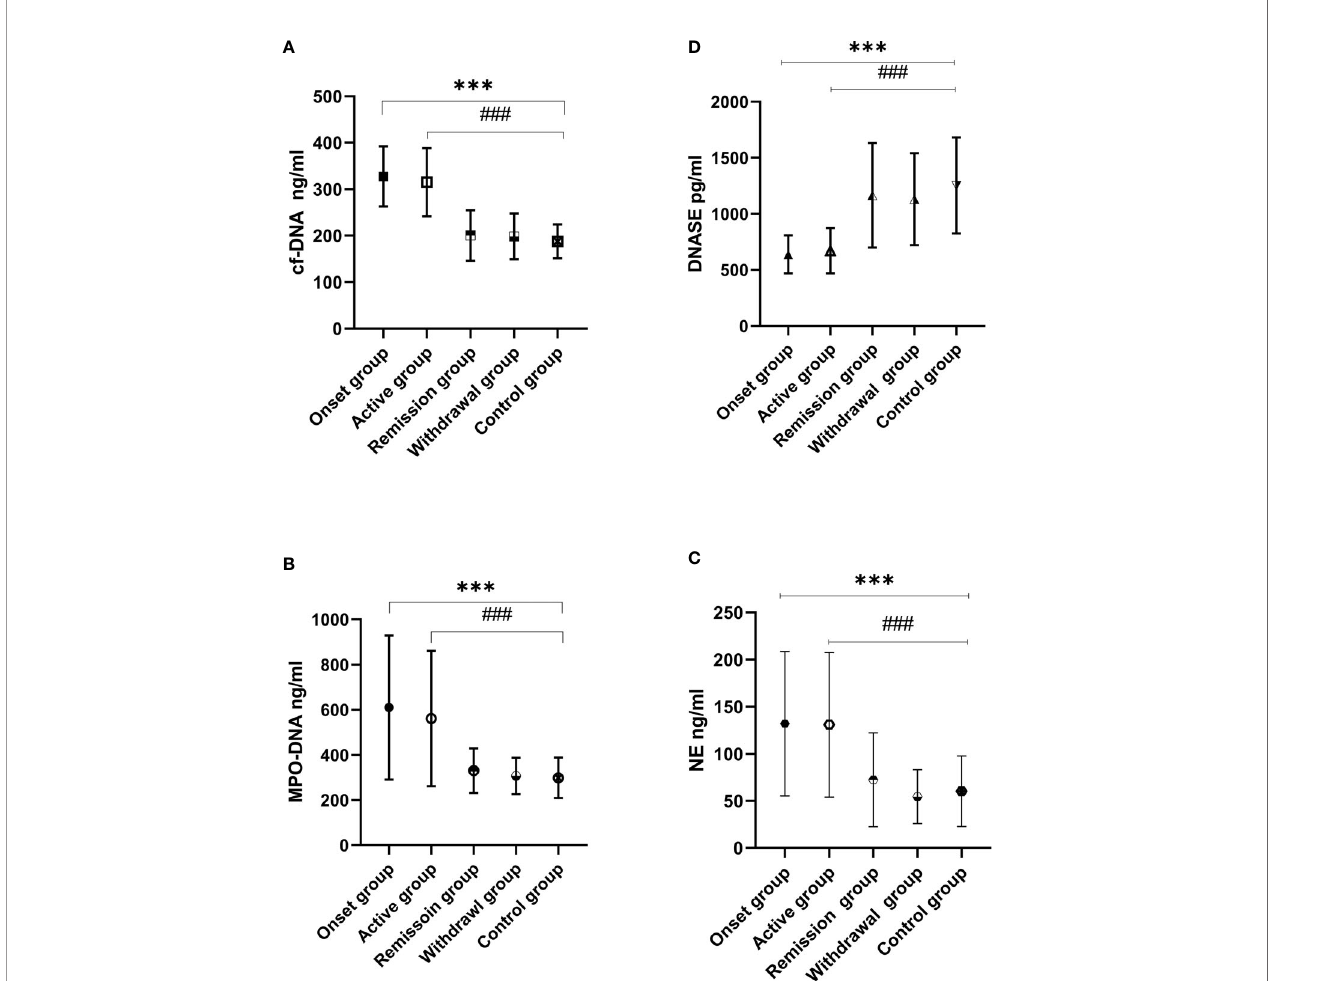
FIGURE 1 | Circulating cf-DNA, MPO-DNA, NE, and DNase I levels were assessed in IgAV and control groups. cf-DNA (A) , MPO-DNA (B) , and NE (C) were elevated in the IgAV onset and active groups when compared to the remission, withdrawal, and control groups ( ### P < 0.001, ***P < 0.001). There were no differences observed between the remission, withdrawal, and control groups (P > 0.05 in all cases). The results were the opposite in DNase I levels (D) which were lower in the onset and active groups when compared with those in the withdrawal, remission, and control groups ( ### P < 0.001, ***P <